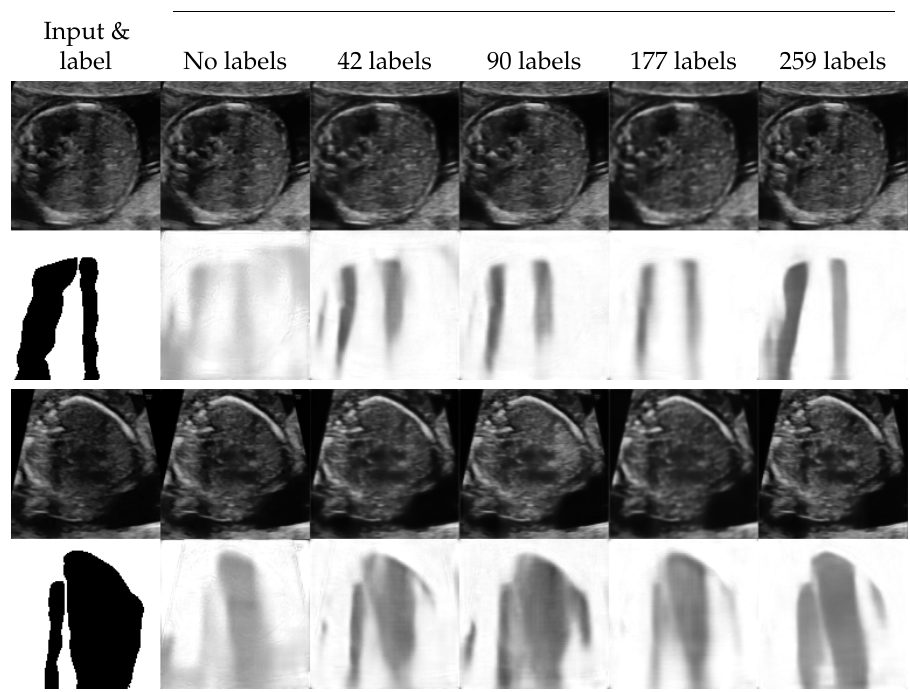
Figure 4. Examples of shadow removal results of the proposed method. The lower side of each example shows the labels and the detection results The upper side shows the input images and the estimated shadow-free